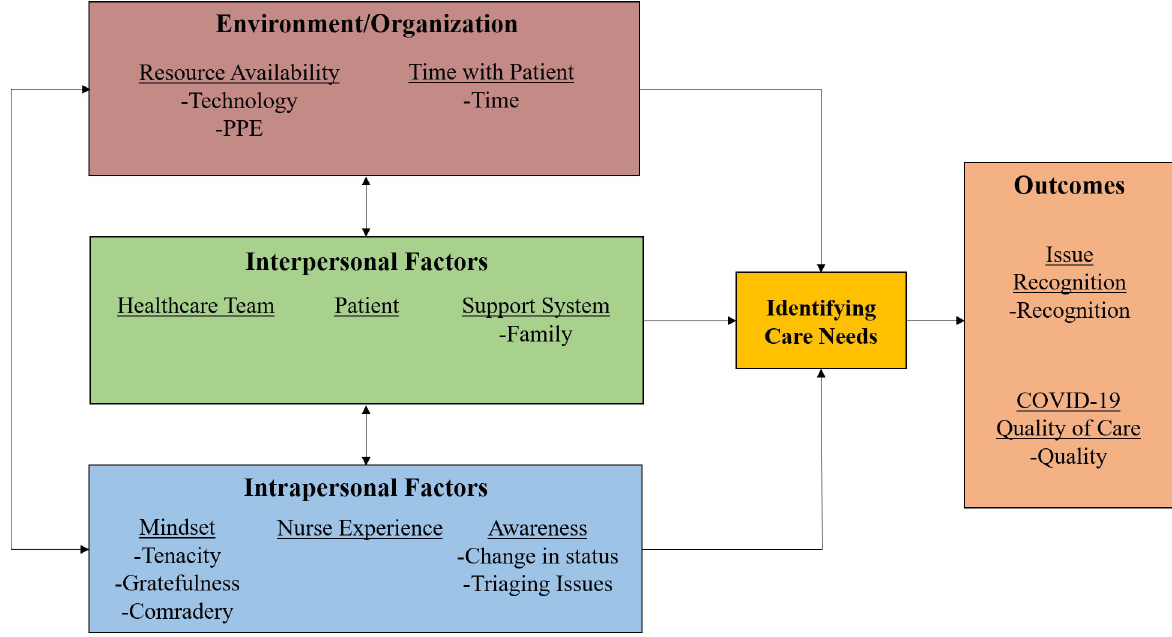
Fig 3. Impact of COVID-19 on nursing care processes and care